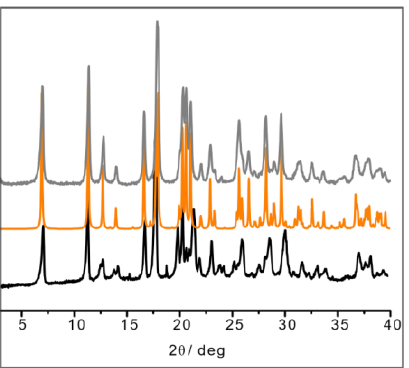
Figure 4. XRPD of ball-milling product of L-His·Cu (in black); calculated pattern from SCXRD of DL-His·Cu (in orange); XRPD of ball-milling product of DL-His·Cu synthesis (in gray).